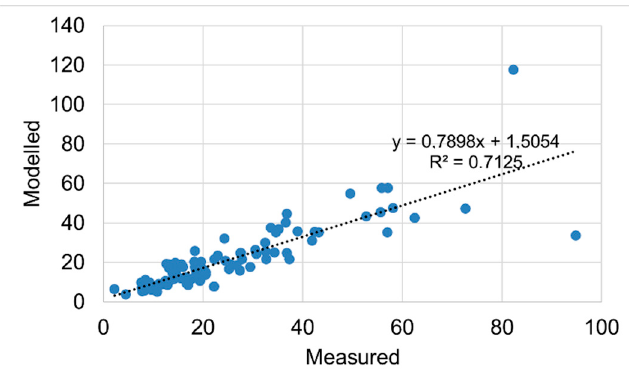
Figure 7. Presents comparison of modelled by PMF and measured PM2.5. data.